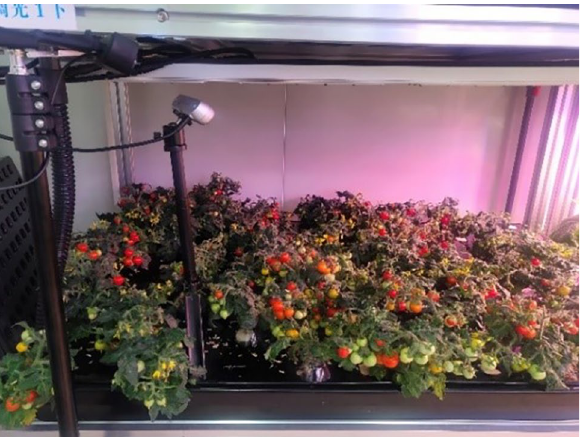
Figure 1. Micro-Tom dwarf tomatoes planted in the PFAL laboratory of our university and its image acquisition